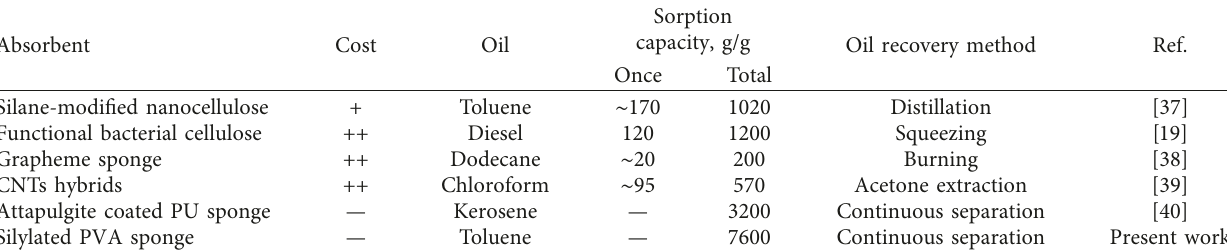
Figure 8: (a) The absorption flux and (b) the separation efficiency of the silylated PVA sponge for oil and organic solvents during 1-hour separation. Table 1: Comparison of the absorption capability of various